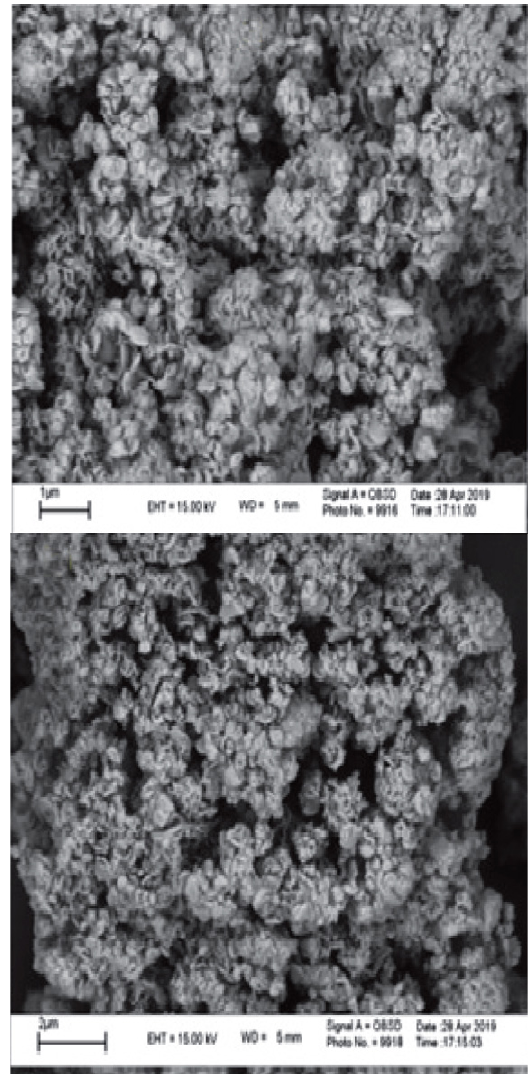
Figure 2. SEM image of fabricated